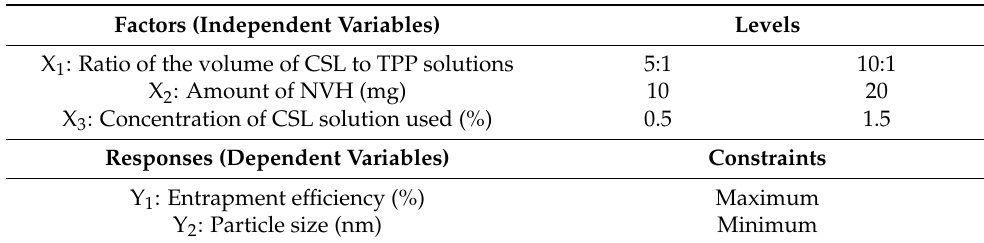
Table 1. The independent and dependent variables for the full factorial design used for preparing NVH-loaded chitosomal systems.